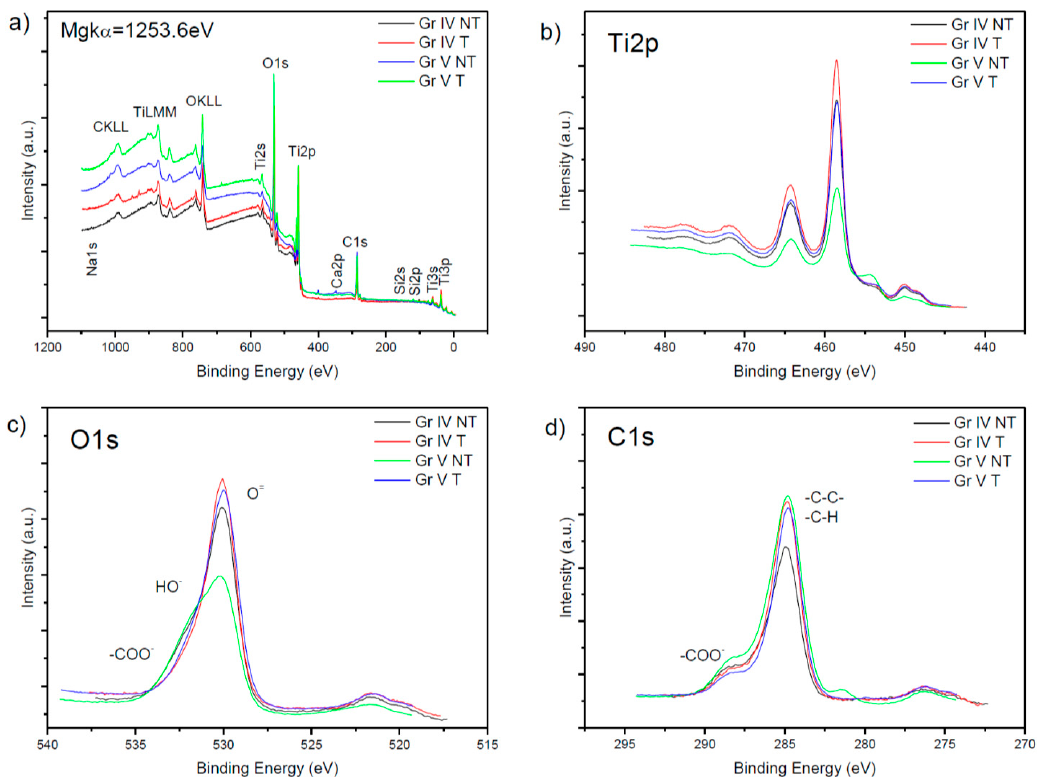
Figure 2. General spectrum, ( a ) of Ti2p regions, ( b ), O1s, ( c ), and C1s, ( d ) of untreated grade IV samples (black line) and treated (red line) and untreated grade V (green line) and treated (blue line) samples. (GR IV: Titanium grade IV; GR V: Titanium grade V; T: SLA treated; NT: SLA non-treated).